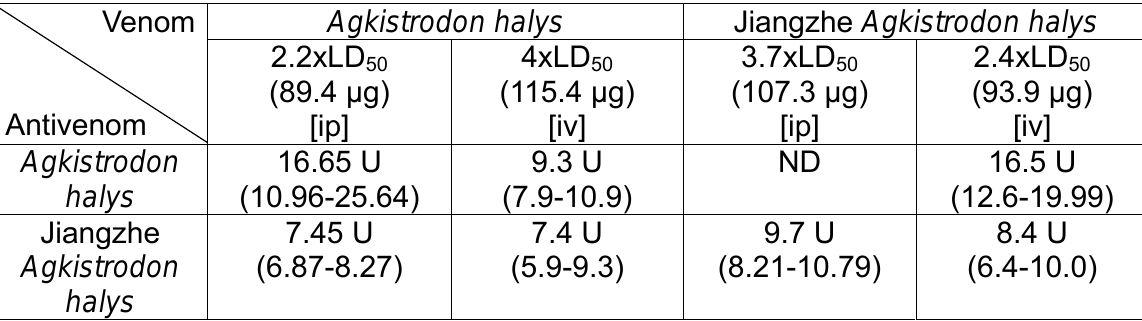
Table 3: Cross-neutralization tests in mice (neutralizing unit of antivenom/1 Test Dose [µg] of snake